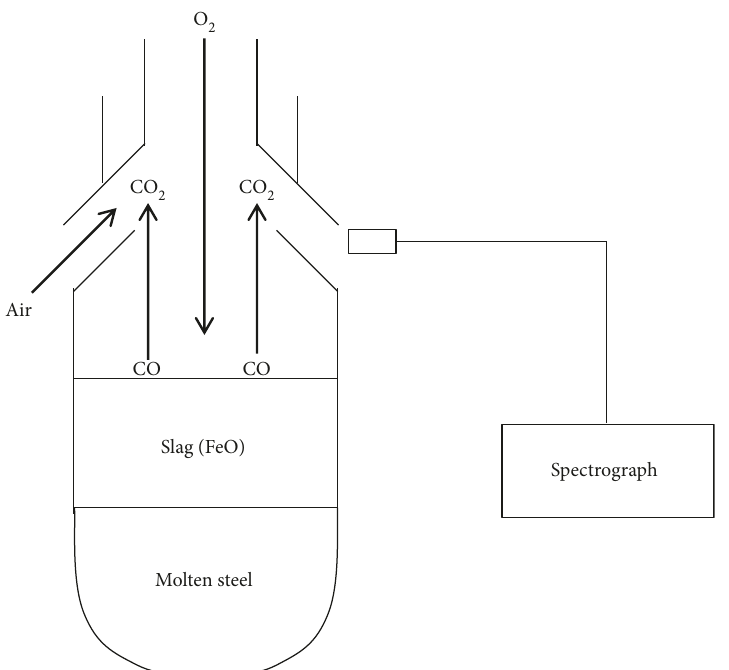
Figure 2: Schematic diagram of a basic oxygen